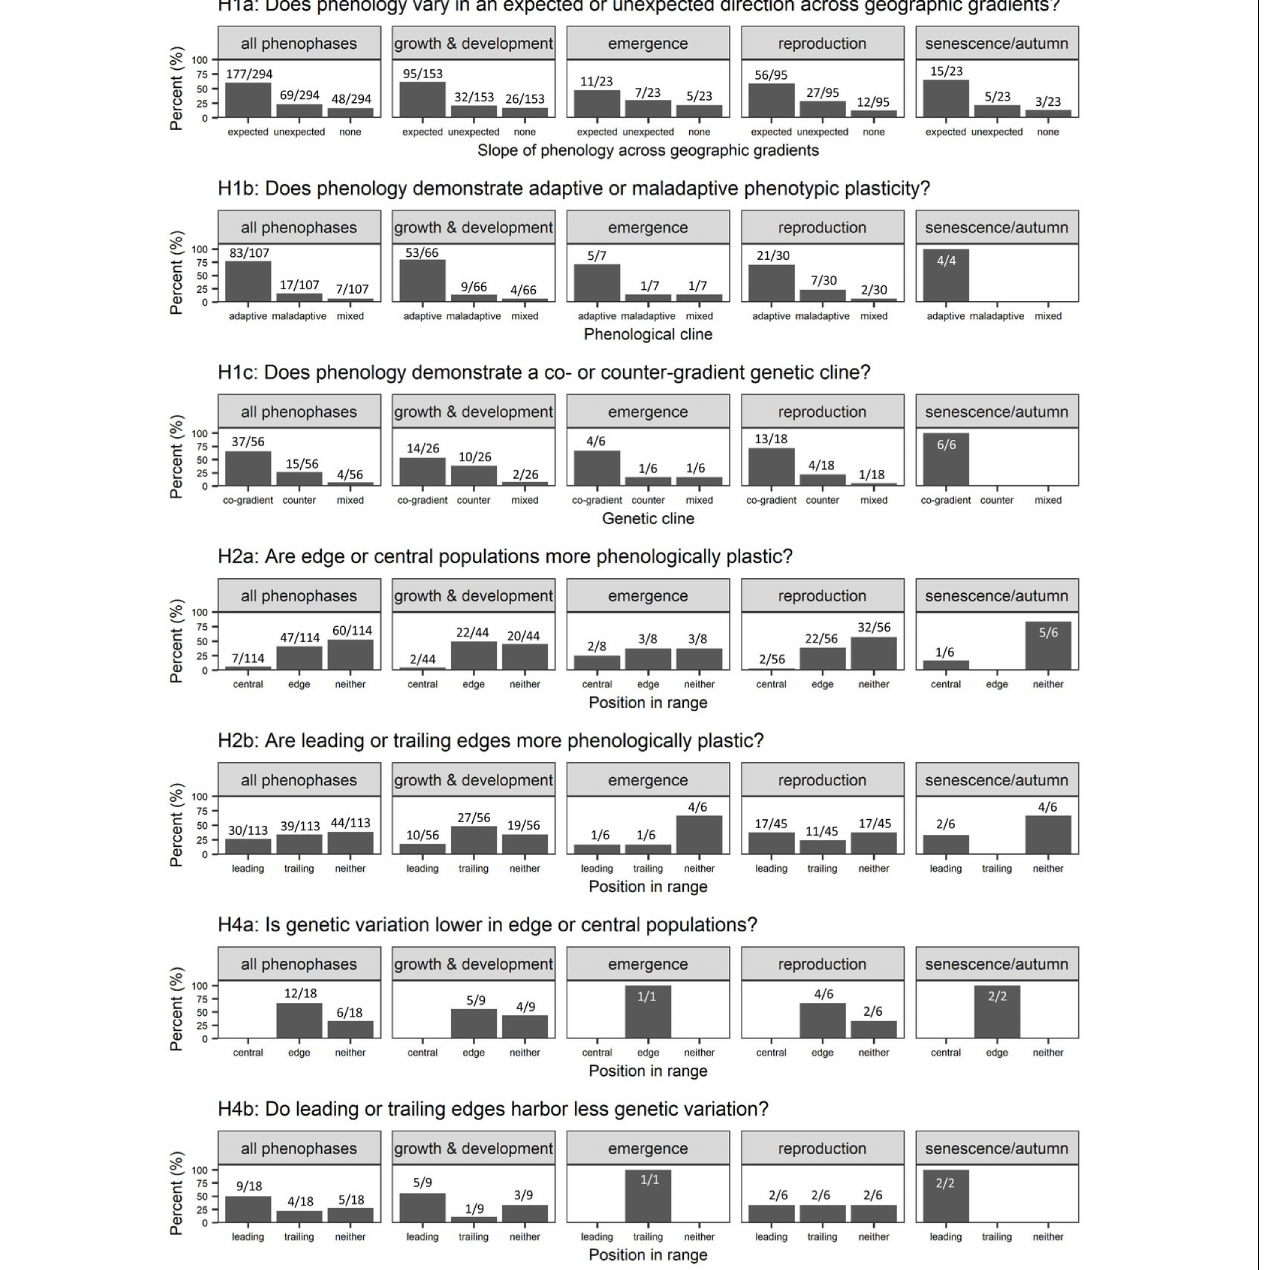
FIGURE 3 | Percent of cases supporting each of the hypotheses outlined for (left to right) all phenophases combined, growth and development, emergence, reproduction, and senescence/autumn phenology. Values represent the number of cases for or against each hypothesis out of the total number of cases that addressed that hypothesis. (H1a) We examine whether the leading edge (i.e., higher latitude or elevation) populations demonstrate delayed spring phenology (growth and development, emergence, and reproduction) and earlier autumn phenology relative to trailing edge (i.e., lower latitude or elevation) populations. “Expected” slopes indicate that phenology follows this pattern; “unexpected” indicates the reverse; “none” indicates no pattern across a geographic gradient. (H1b) We examine whether phenology demonstrates adaptive phenotypic plasticity (i.e., phenological plasticity is in the same direction as the geographic cline and so shifts phenotypes in the direction that would be adaptive in the novel environment), maladaptive plasticity (i.e., phenological plasticity is not consistent with the geographic cline), or mixed evidence. (H1c) We examine whether phenology demonstrates co-gradient genetic clines (i.e., many populations grown in a common environment demonstrate phenological plasticity consistent with the geographic and phenotypic cline), a counter-gradient genetic cline (“counter”), or mixed evidence. For (H2), we examine whether (H2a) edge versus central and (H2b) leading vs. trailing edge populations (or neither) demonstrate greater phenological plasticity, respectively. (H3) is not shown on this figure due to low sample size. For (H4), we examine whether (H4a) edge vs. central and (H4b) leading vs. trailing edge populations (or neither) demonstrate lower genetic variation in phenological traits, respectively.